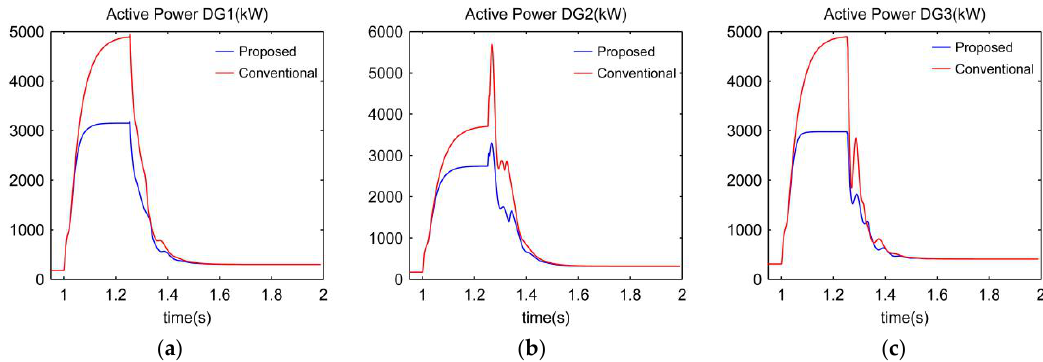
Figure 21. Power of DG units in short circuit condition using proposed supplementary control compare with conventional droop controller ( a ) DG1; ( b ) DG2; and ( c )